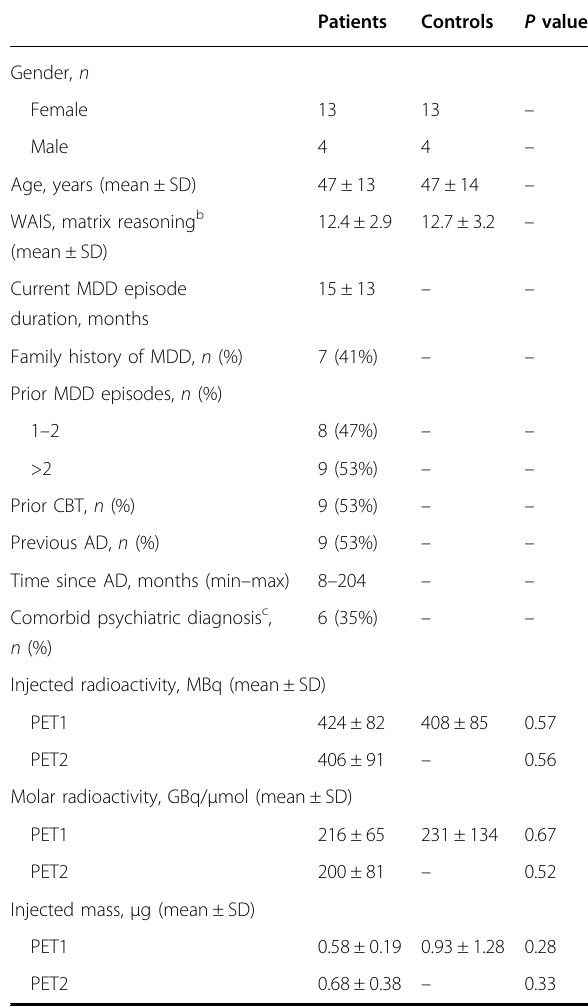
Table 1 Demography and radioactivity